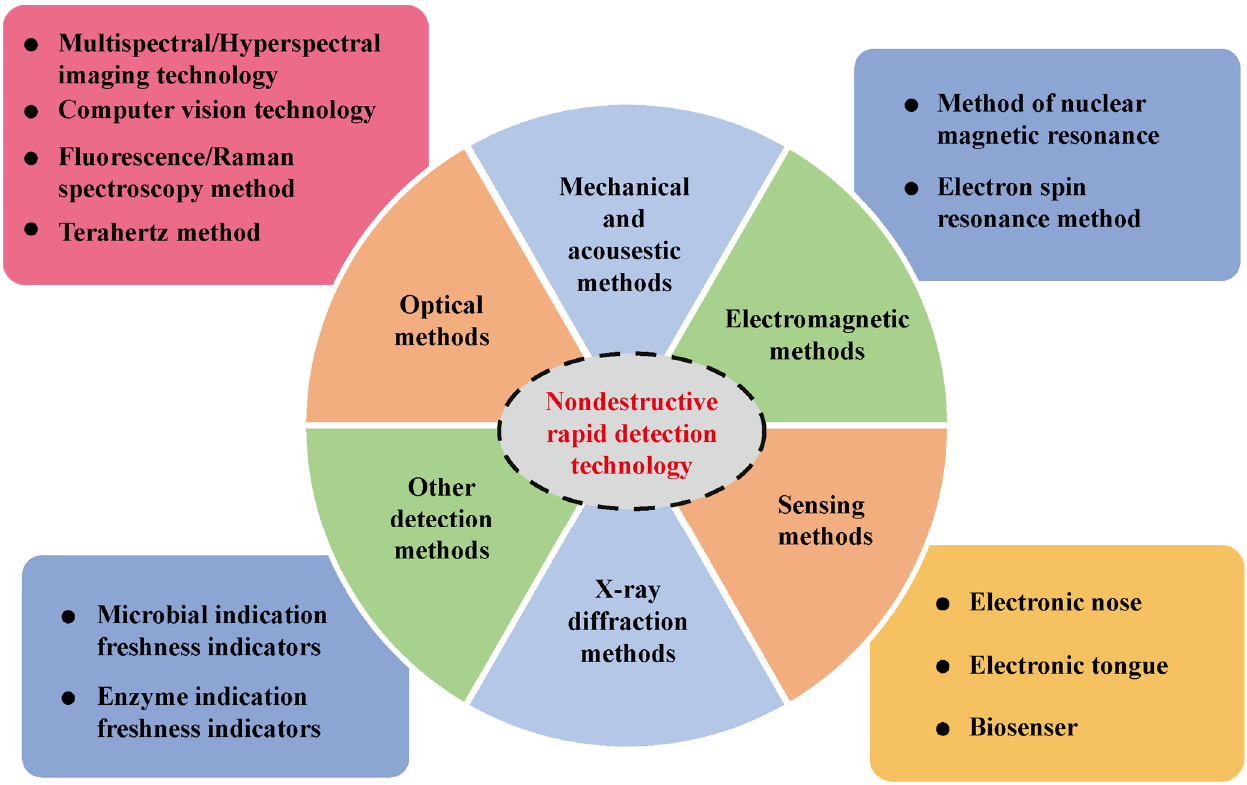
Figure 1. Classification scheme for nondestructive rapid detection techniques in food analysis.